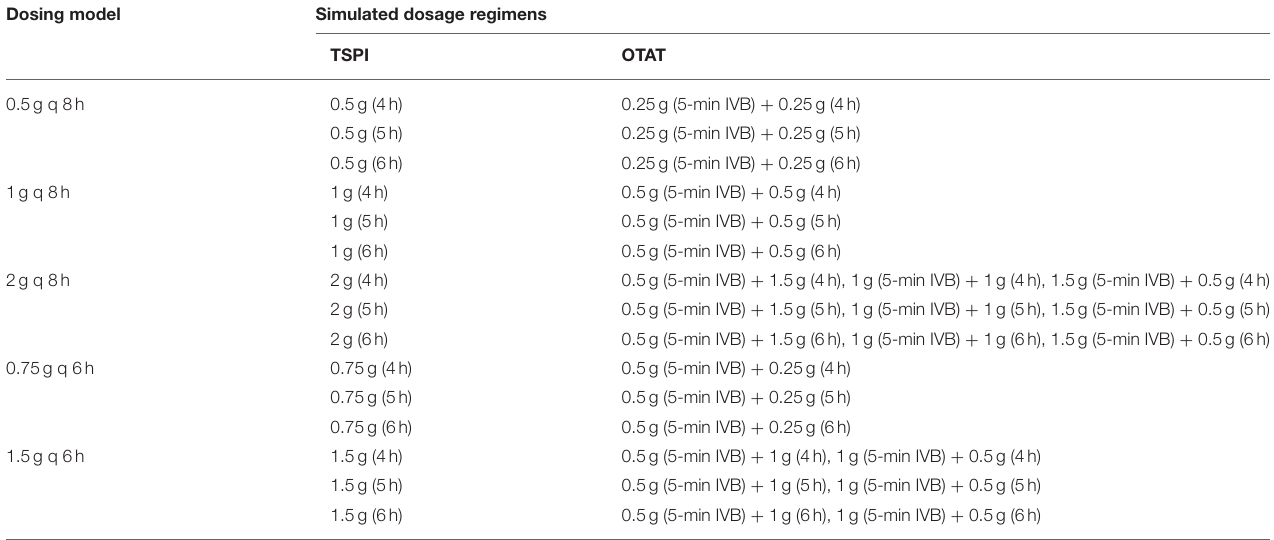
TABLE 1 | Simulated dosage regimens for meropenem. Dosing